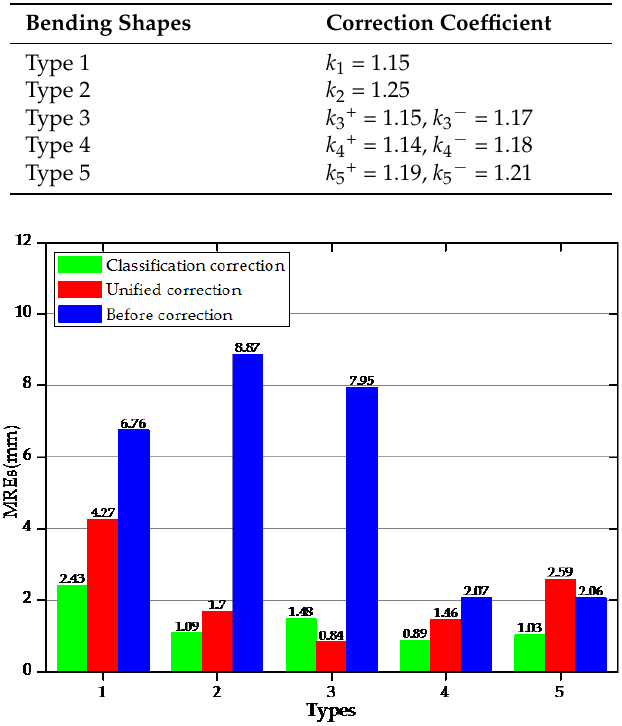
Figure 10. Comparison of MREs based on different correction methods under five bending shapes.